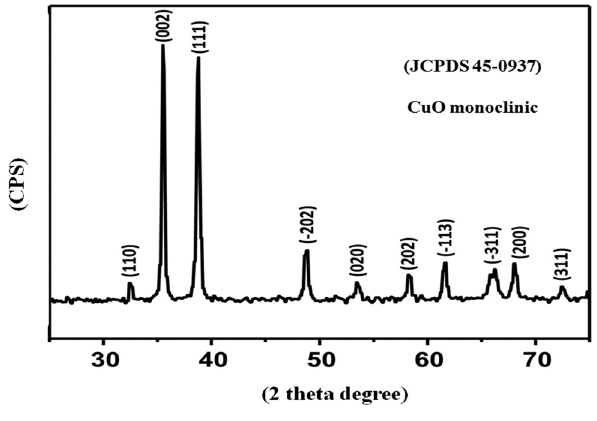
Figure 1: XRD patterns of CuO